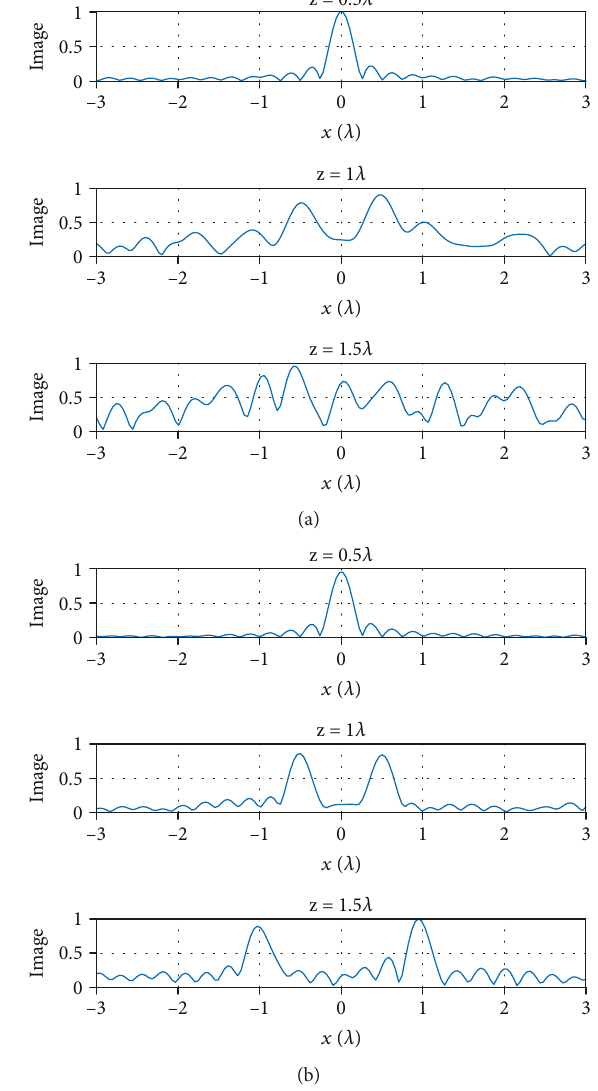
Figure 7: Reconstructed images when using 13 resonant dipole antennas. For this example, the parameters are z z =1.5 λ , d = λ , d =2 λ , s = λ /8, and (a) D =0.125 λ (b) D =0.5 λ . 3 2 3 These results are with SNR=20 dB. Figure =0.5 λ , z = λ , 1 2